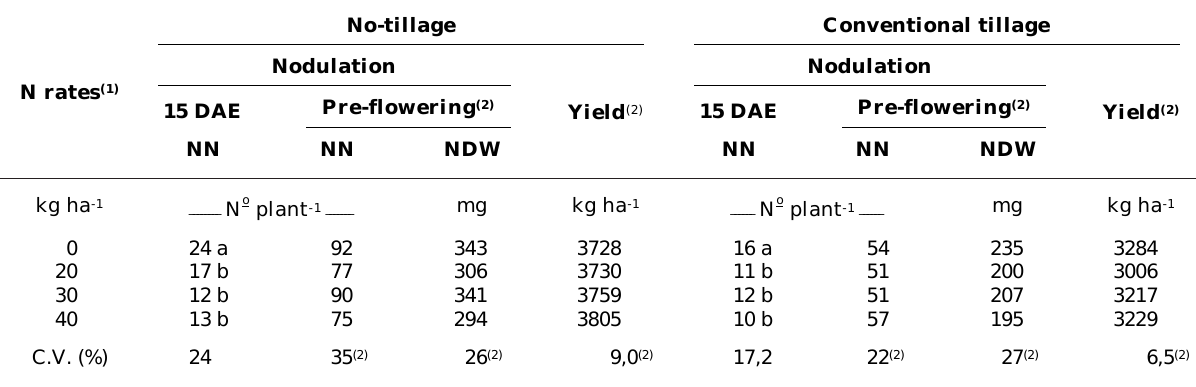
Table 2. Effects of starter N rates on nodulation per plant (nodule number, NN; nodule dry weight, NDW), and on grain yield of the soybean cultivar Celeste grown under no-tillage (NT) and conventional tillage (CT) systems, in